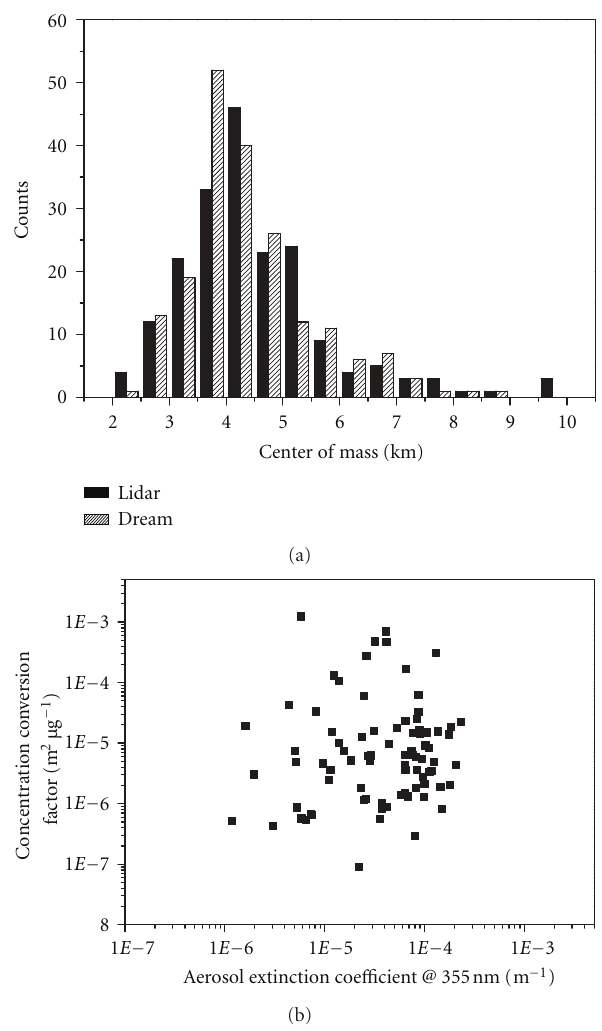
Figure 8: Results of DREAM evaluation through EARLINET meas- urements performed over Potenza [227]: counts distribution of center of mass of the identified Saharan dust layers (a) and evaluated concentration conversion factor as a function of the extinction coe ffi cient as measured by lidar